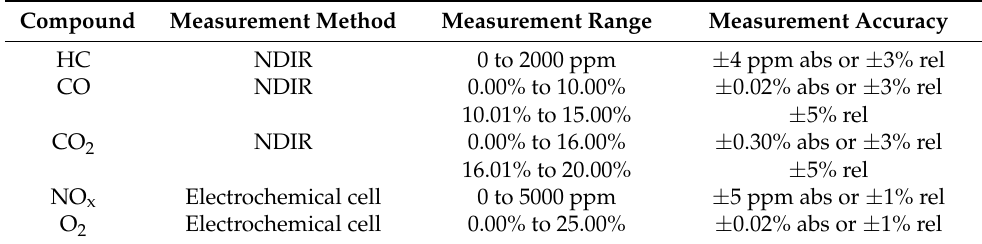
Figure 2. C onnection ports of the Axion portable gas analyzer. Figure 2. Connection ports of the Axion portable gas analyzer. Table 1. AXION OEM-2100 AX specifications. Table 1. AXION OEM-2100 AX